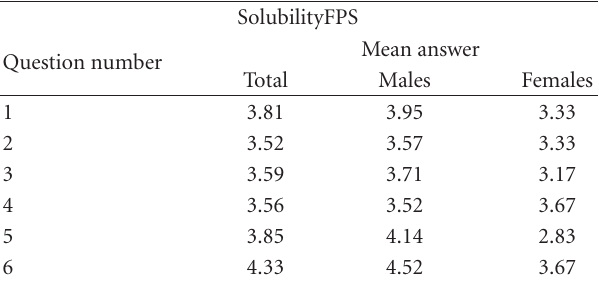
Table 5: List of mean answers for the SolubilityFPS game.